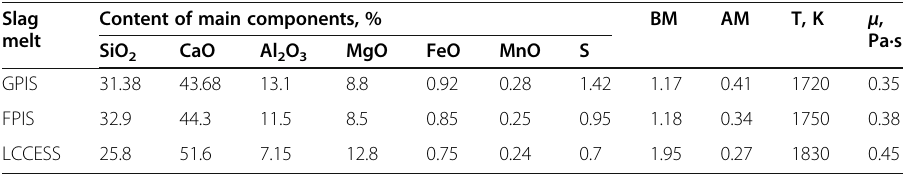
Table 1 Types and main indicators of processable slag melts Slag Content of main components, % B М melt